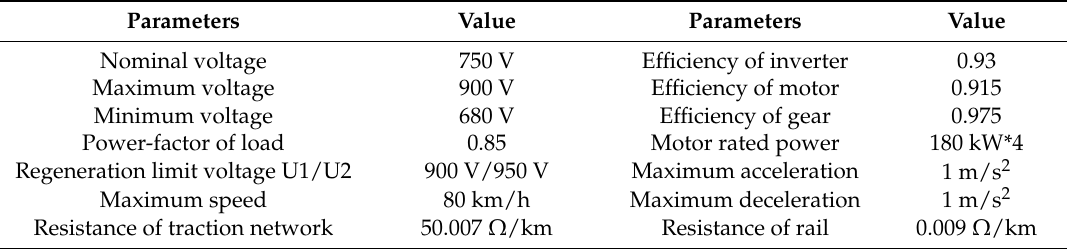
Table 2. Train and line parameters.